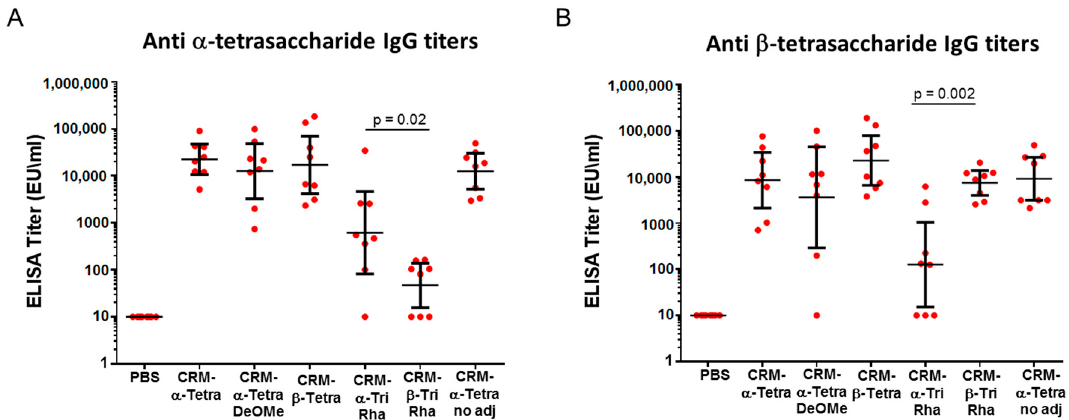
Figure 5. IgG levels after the second boost in mice immunized with the different conjugated fragments, with and without Alum, using α -tetrasaccharide-BSA ( A ) and β -tetrasaccharide-BSA ( B ) for coating. PBS was the negative control. Horizontal large bars indicate geometric mean titers (GMT) of each group, with 95% statistical confidence intervals indicated by small bars. Mann–Whitney analysis was used for statistics of α -Trirha-CRM 197 vs. β -Trirha-CRM 197 .